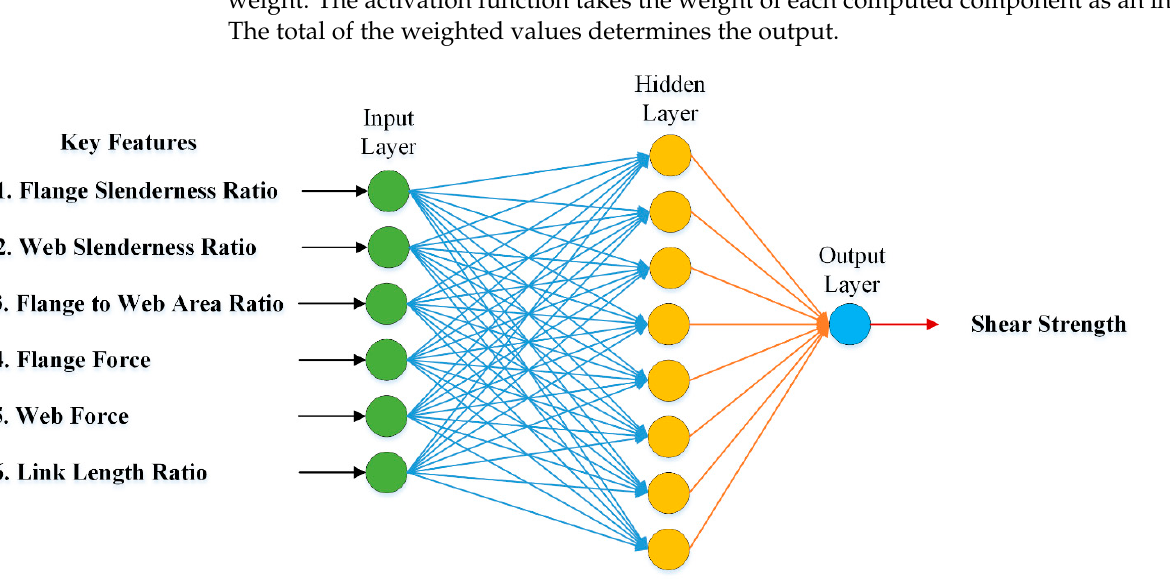
Figure 2. The architecture of the 𝐴𝑁𝑁 to estimate the short links’ shear